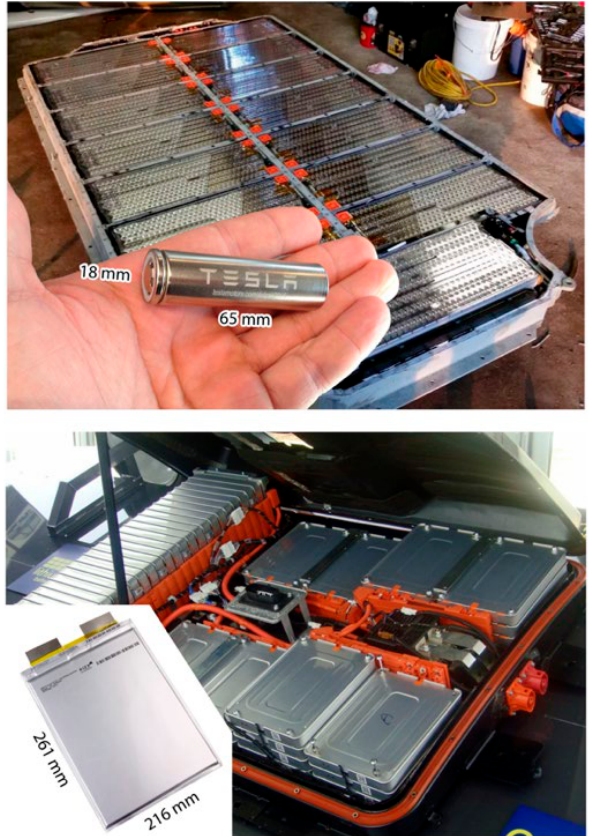
Figure 6. Individual cells for BEVs and their final assembly in the pack: Tesla (cylindrical, top) and Nissan Leaf (puch,